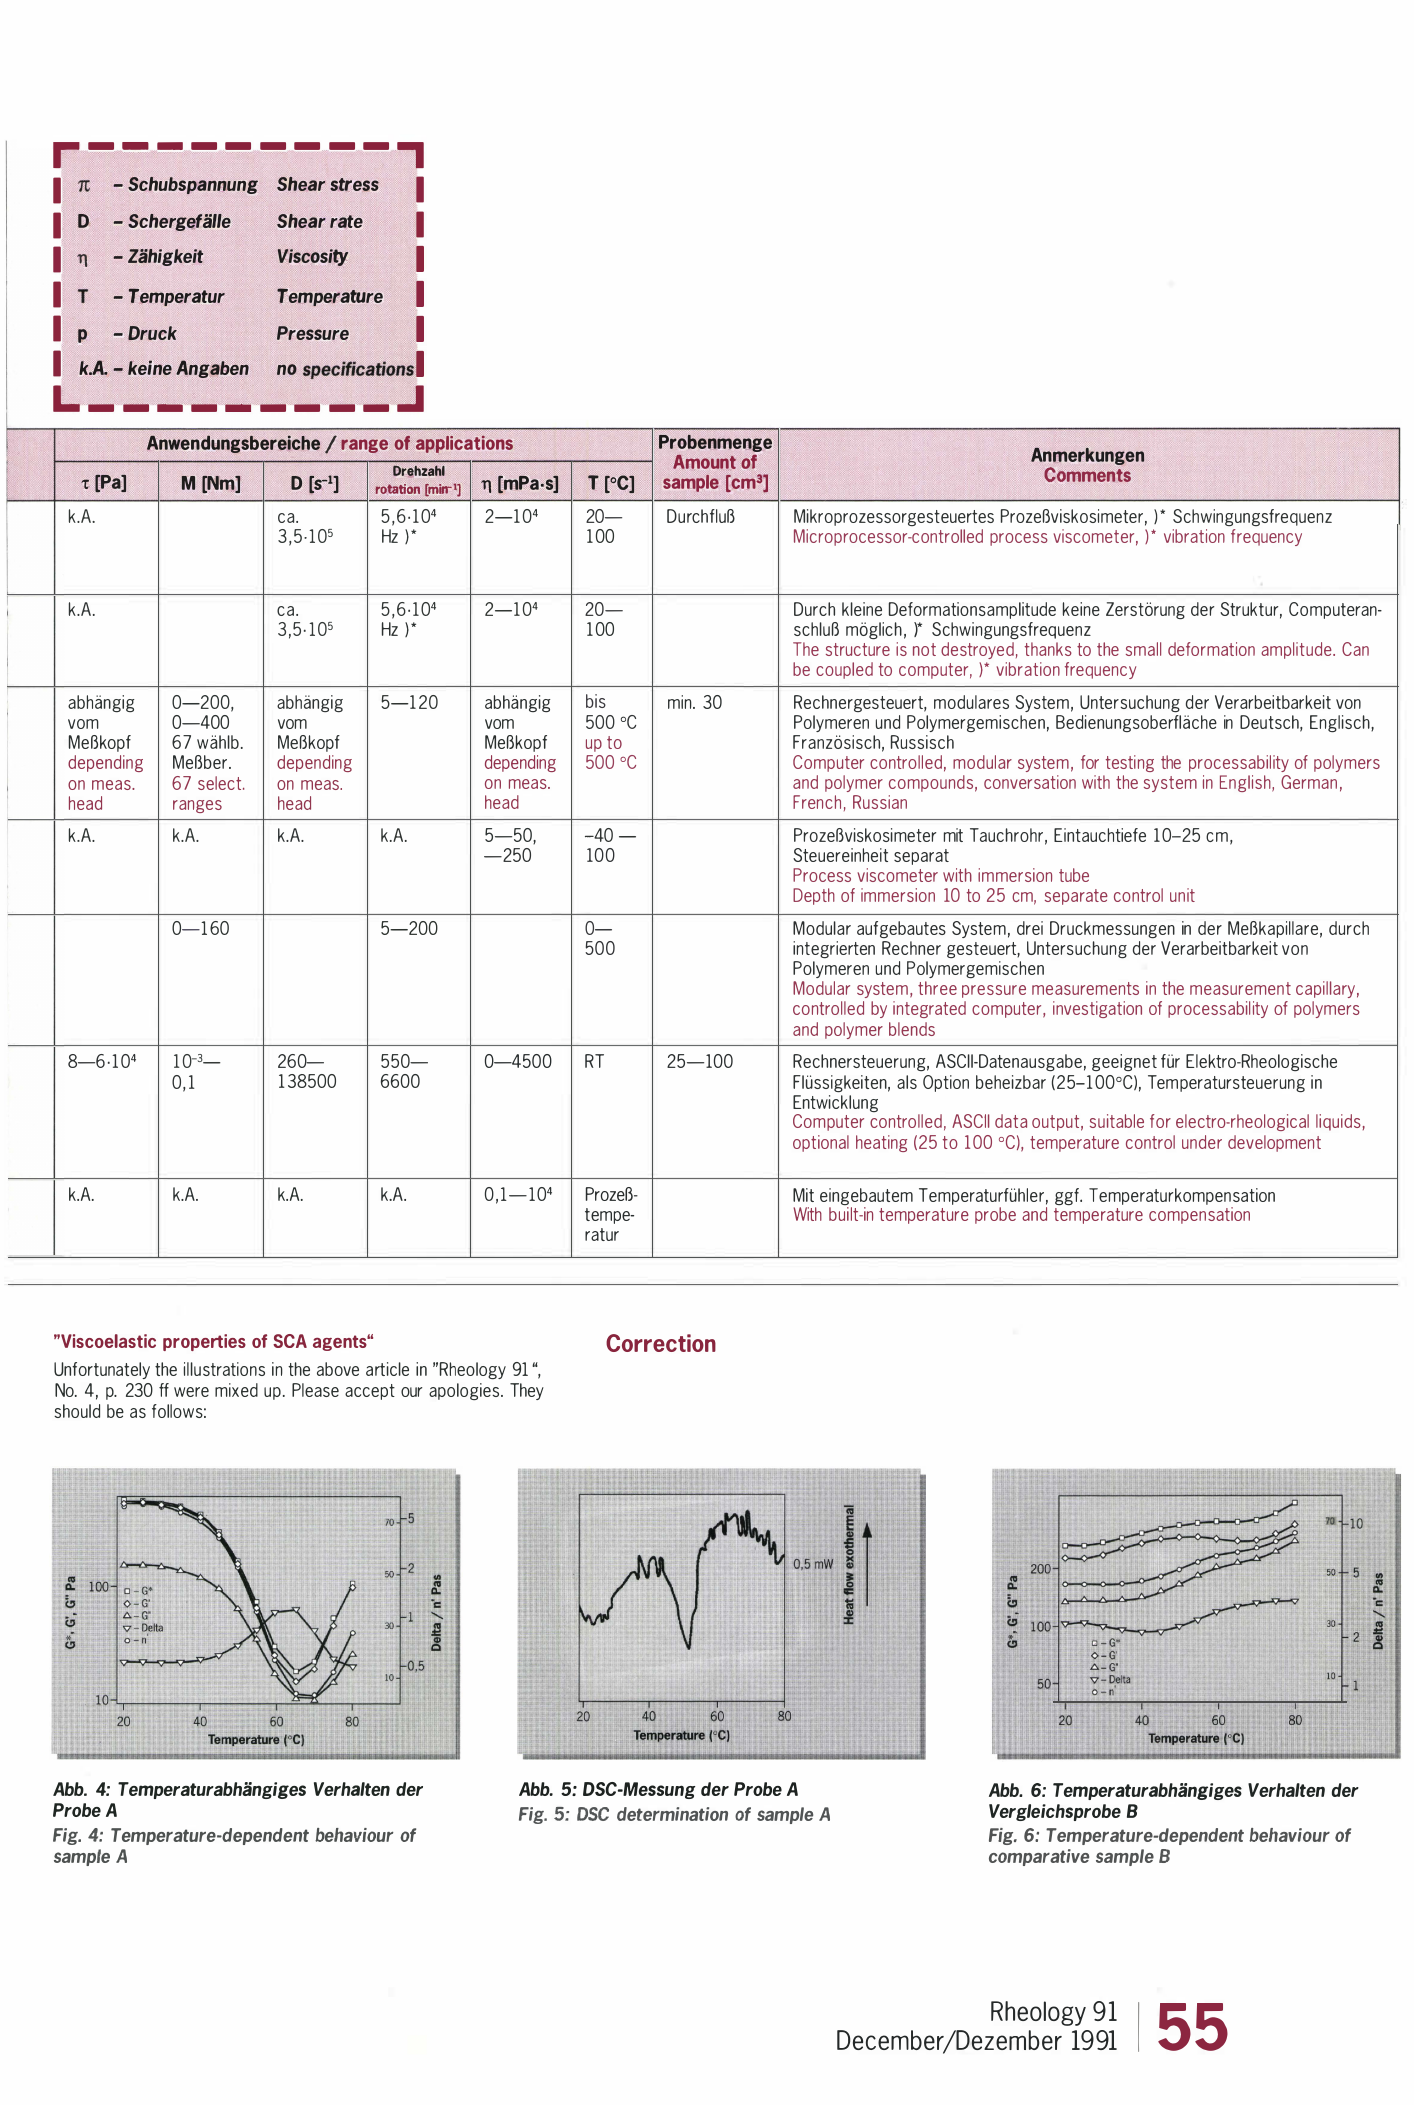
Abb. 5: DSC-Messung der Probe A Fig. 5: DSC determination of sample A